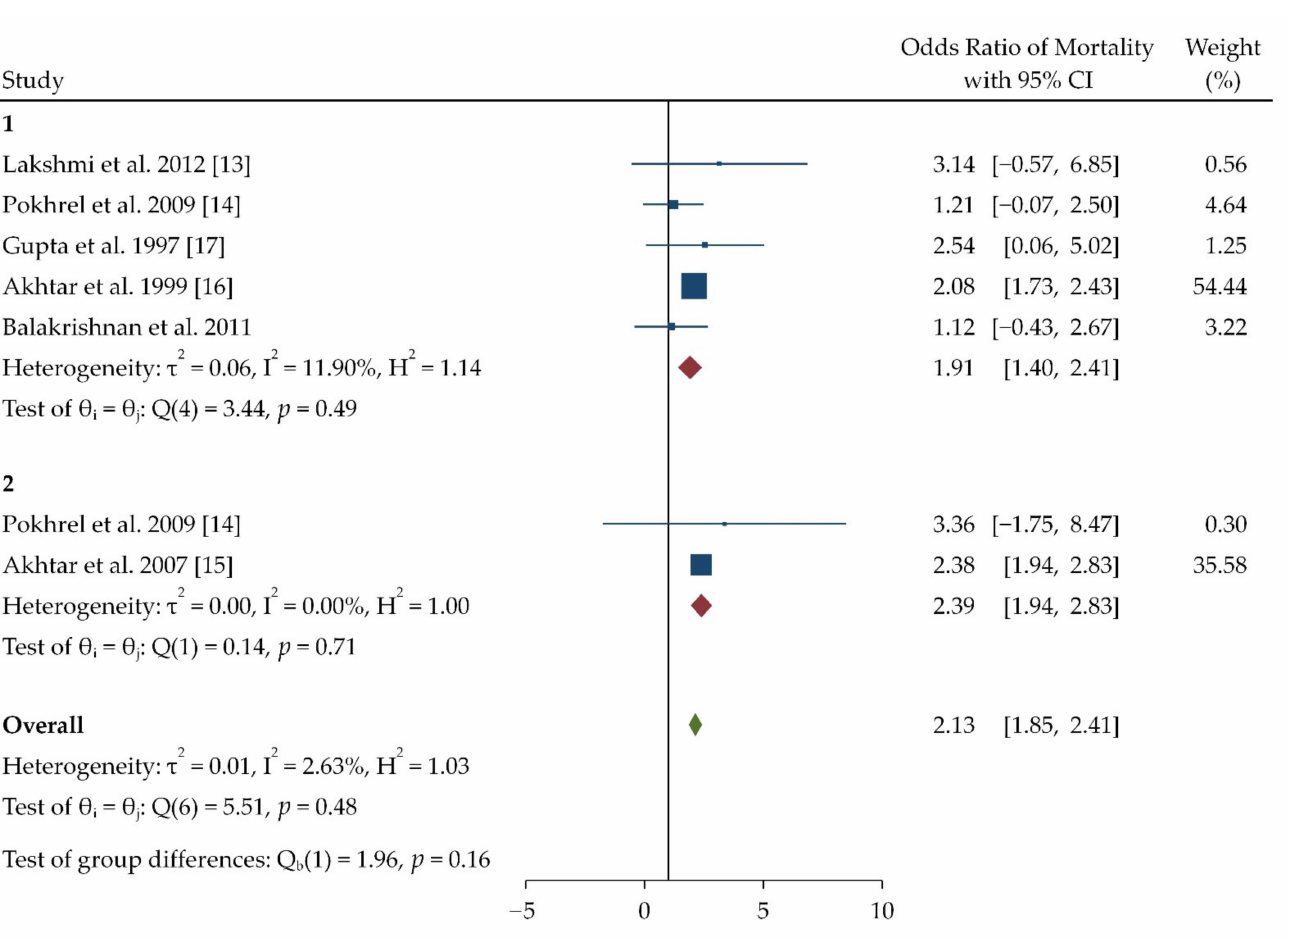
Figure 2. Forest plot of odd’s ratio for chronic obstructive pulmonary disease (COPD) mortality. The plot has been generated using Random effects Restricted maximum likelihood (REML) model. The forest plot has been given in terms f pollutant which have been assessed in respective studies. The number represents the pollutant which the studies have assessed, which is as follows: 1 = Biomass; 2 =